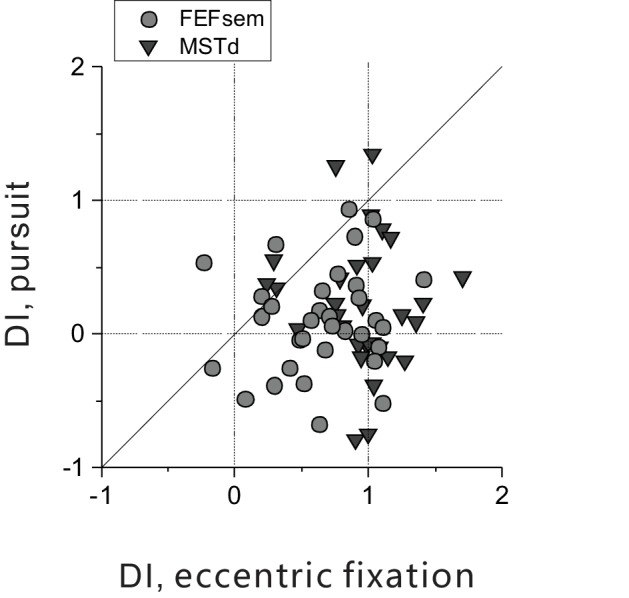
Direct comparison of DI between pursuit and eccentric fixation on a cell by cell basis.Each point represents one neuron. DI for the pursuit protocol was computed in the same way, that is from the whole tuning curve at once as for the eccentric fixation data. Circle: FEFsem, N = 36; Triangle: MSTd, N = 32. DI under pursuit is significantly smaller compared to that under the eccentric fixation task (FEFsem: p=1.9E-4; MSTd: p=6.4E-8, paired t-test), and they are not significantly correlated with each other (p>0.5, Spearman rank correlation). The same data set as Figure 4D.